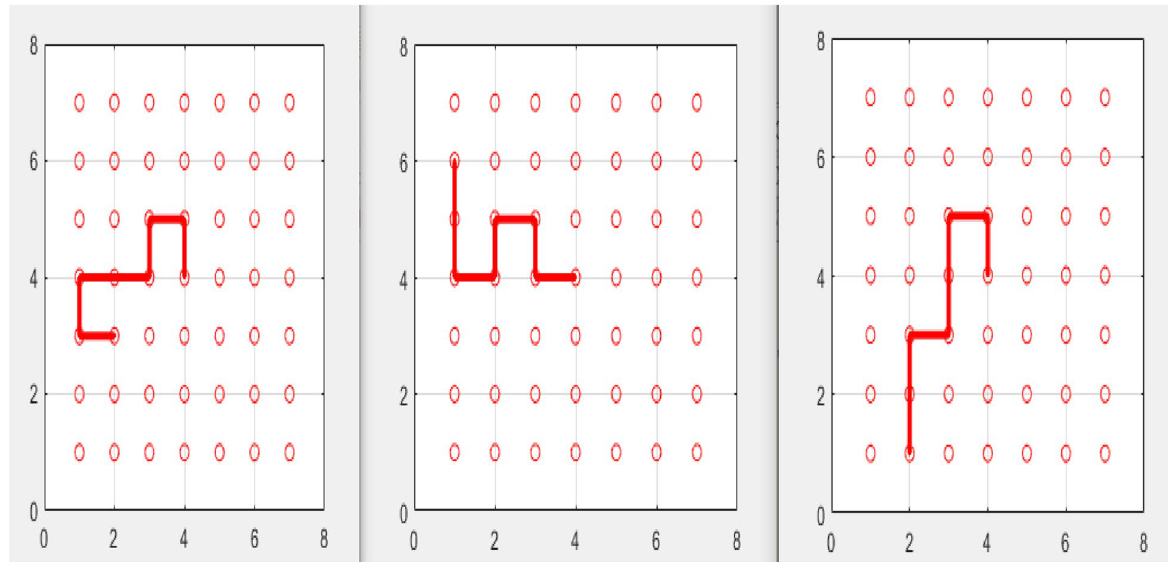
7 units and the size of ensemble (or extent of =